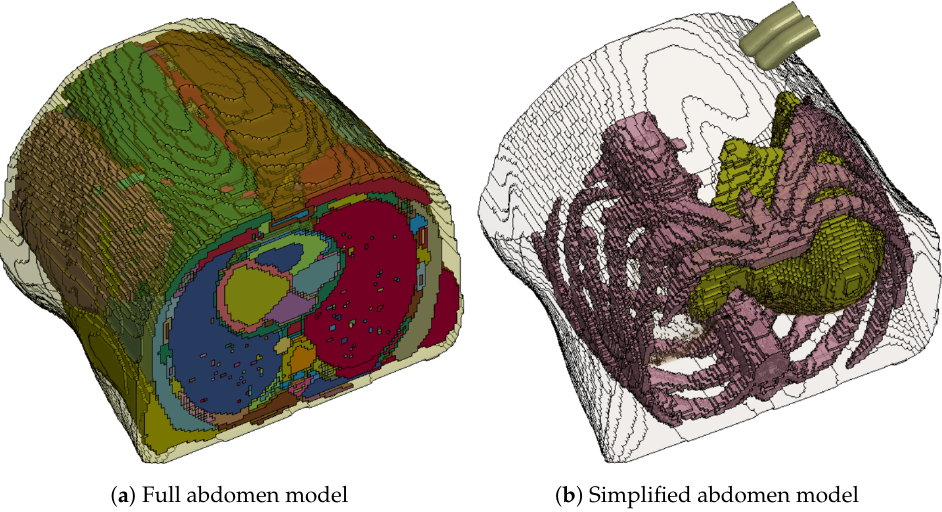
Figure 2. Abdomen model. ( a ) High-fidelity model generated by the XCAT program. ( b ) Simplified abdomen model with lumped abdominal tissue, ribcage, liver, and dummy